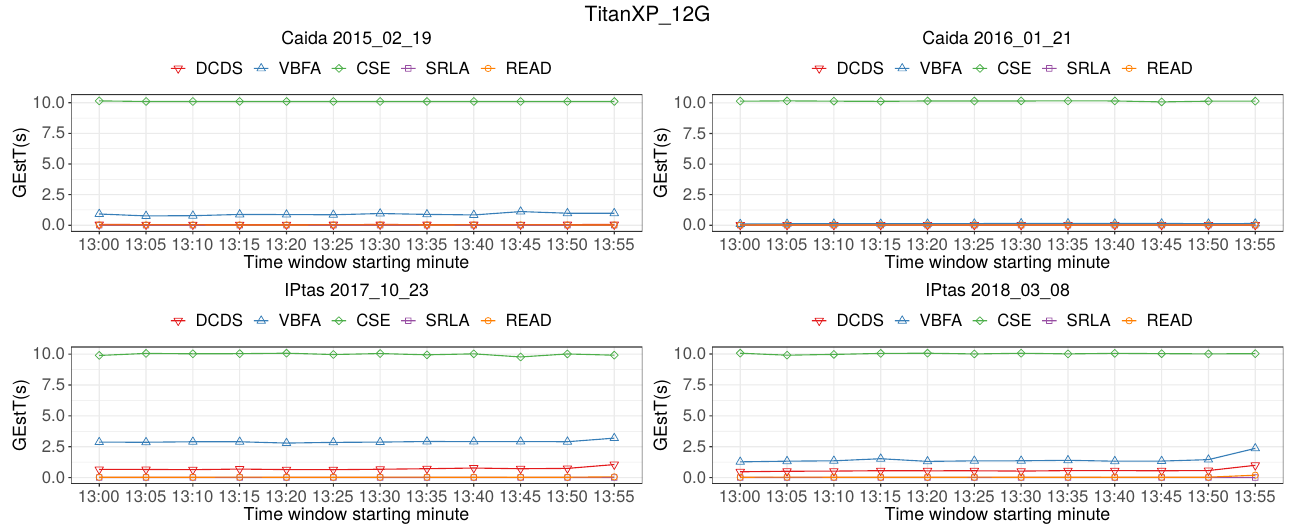
Figure 10. Time of estimate candidate super